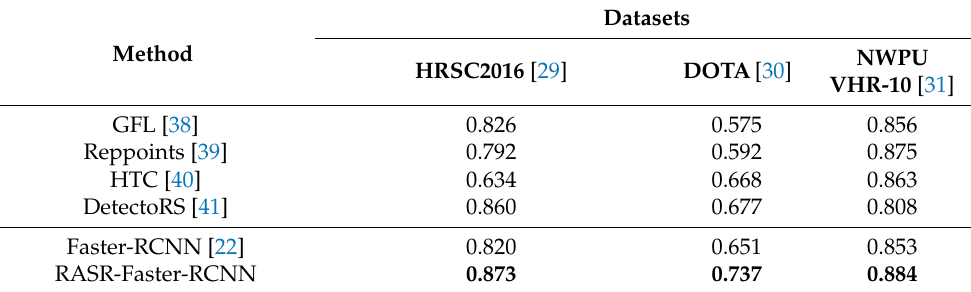
Table 5. Quantitative results (i.e., mAP50) achieved by different methods (based on ResNet101) on the HRSC2016, DOTA and NWPU VHR-10 datasets. Our RASR-Faster-RCNN achieves state-of-the-art detection performance. The best results are in bold